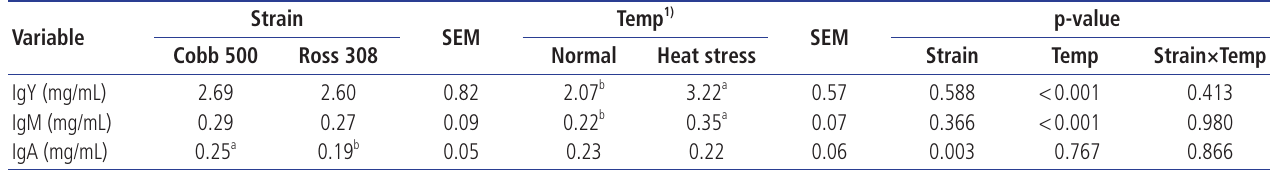
Table 5. Effects of strain and temperature on serum concentrations of IgY, IgM, and IgA in broiler chickens at 35 days of age